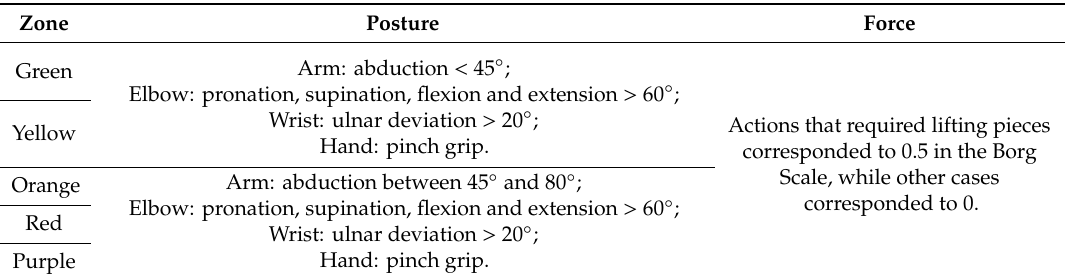
Table 4. Repetitive task parameters designed for this study according to OCRA Index risk levels: Posture and